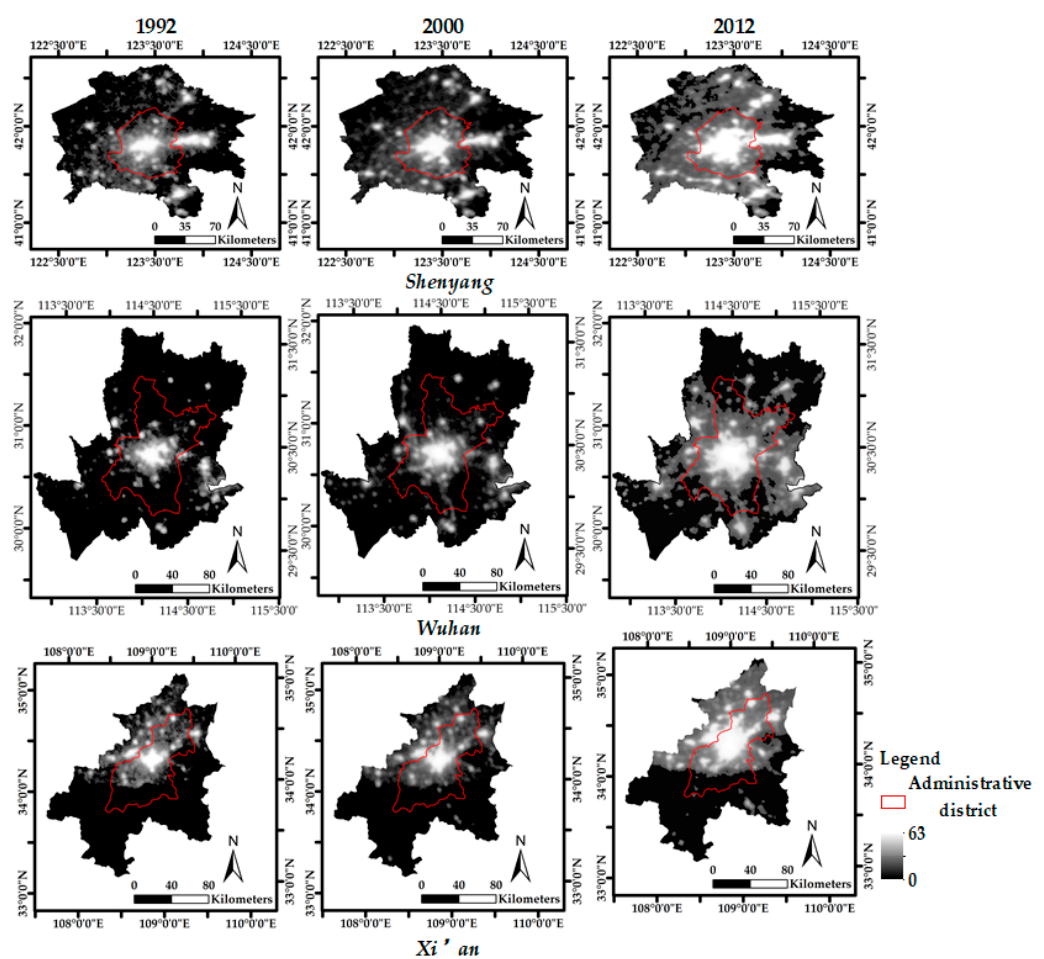
Figure 2. Corrected multitemporal Defense Meteorological Satellite Program—Operational Linescan Figure 2 . Corrected multitemporal Defense Meteorological Satellite Program – Operational Linescan System (DMSP/OLS) System (DMSP/OLS) data.